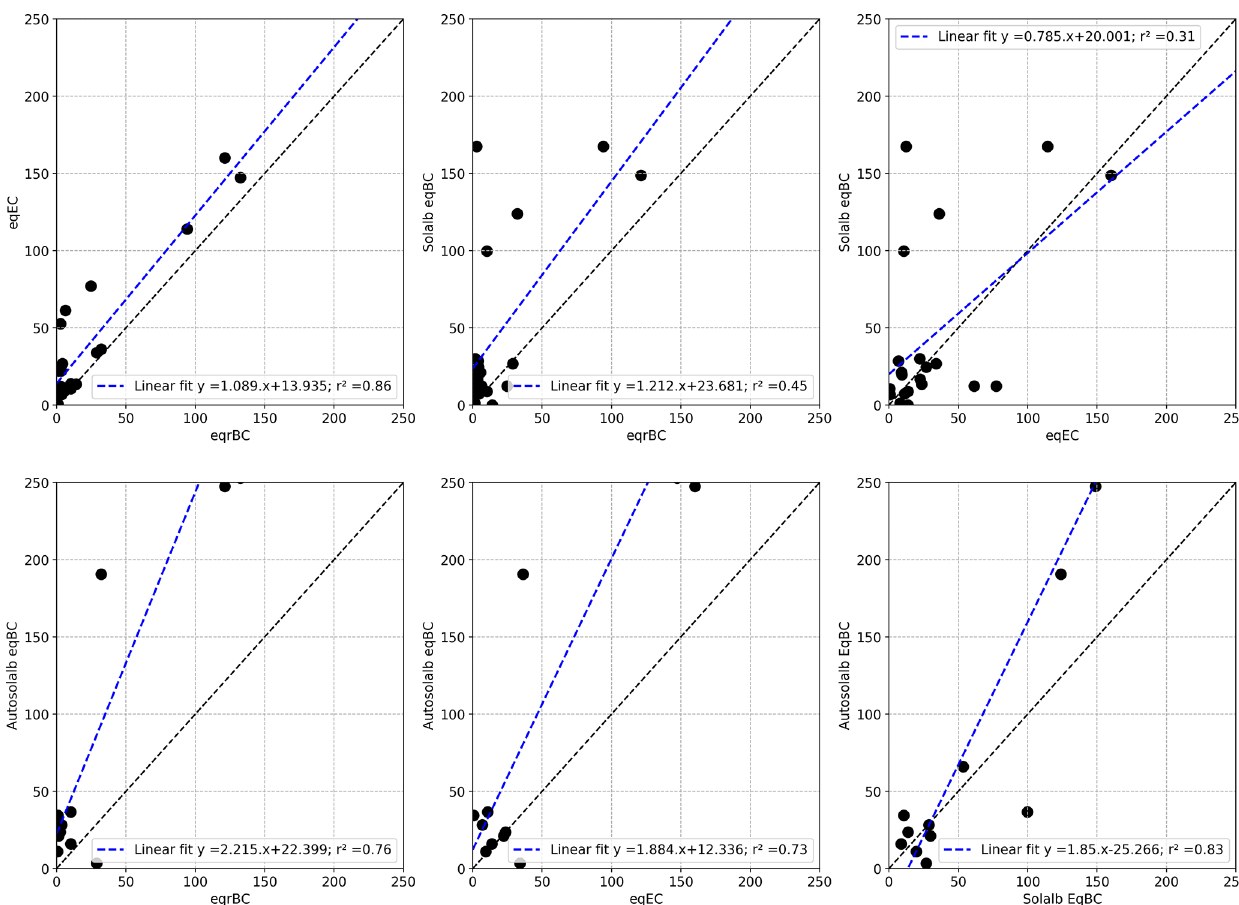
Figure D1. Comparison between the different estimates of near-surface AEC presented in Sect. 3.2.